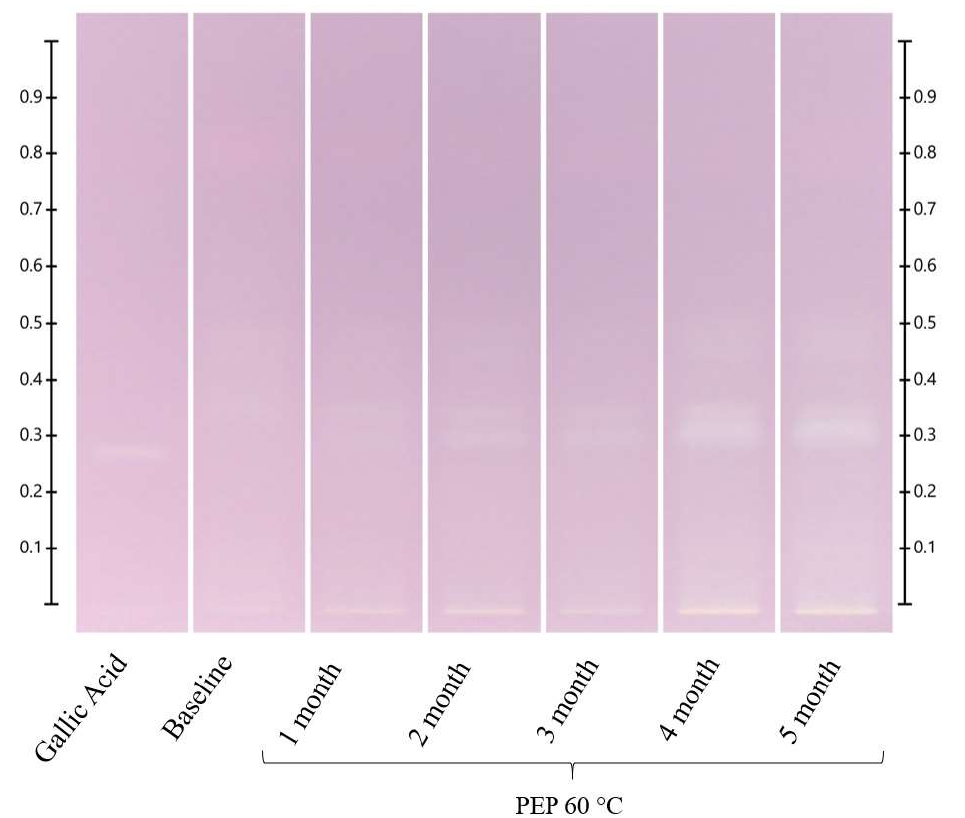
Figure 11. HPTLC-DPPH fingerprints of PEP honey stored at 60 °C for up to 5 months. Images of the HPTLC plate were taken under white light after 60 min of derivatization with DPPH* reagents, gallic acid (4 μL) and honey extracts (5 μL), respectively.